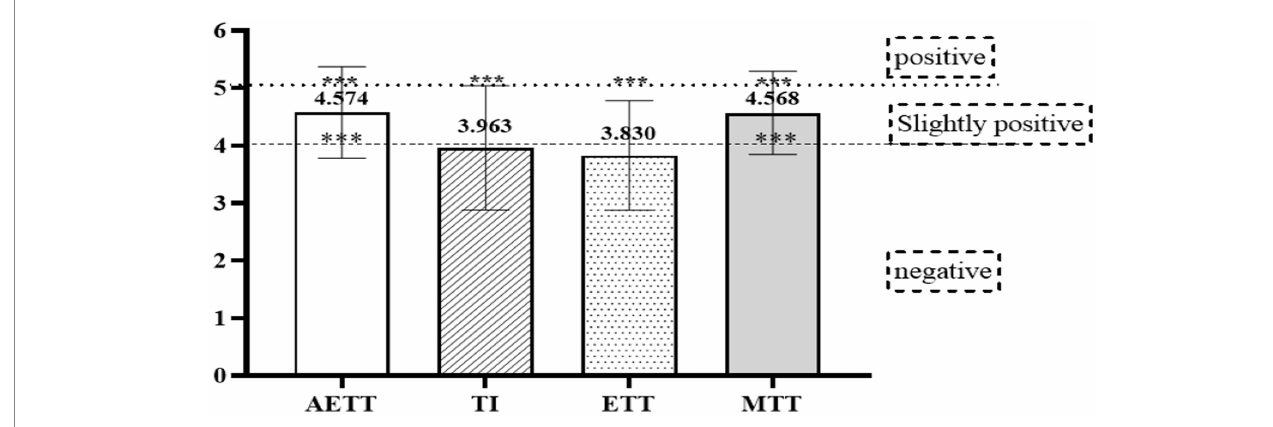
FIGURE 2 Means and one-sample t -test results of four ATT second-order constructs. * p <0.05; ** p <0.01; *** p <0.001.